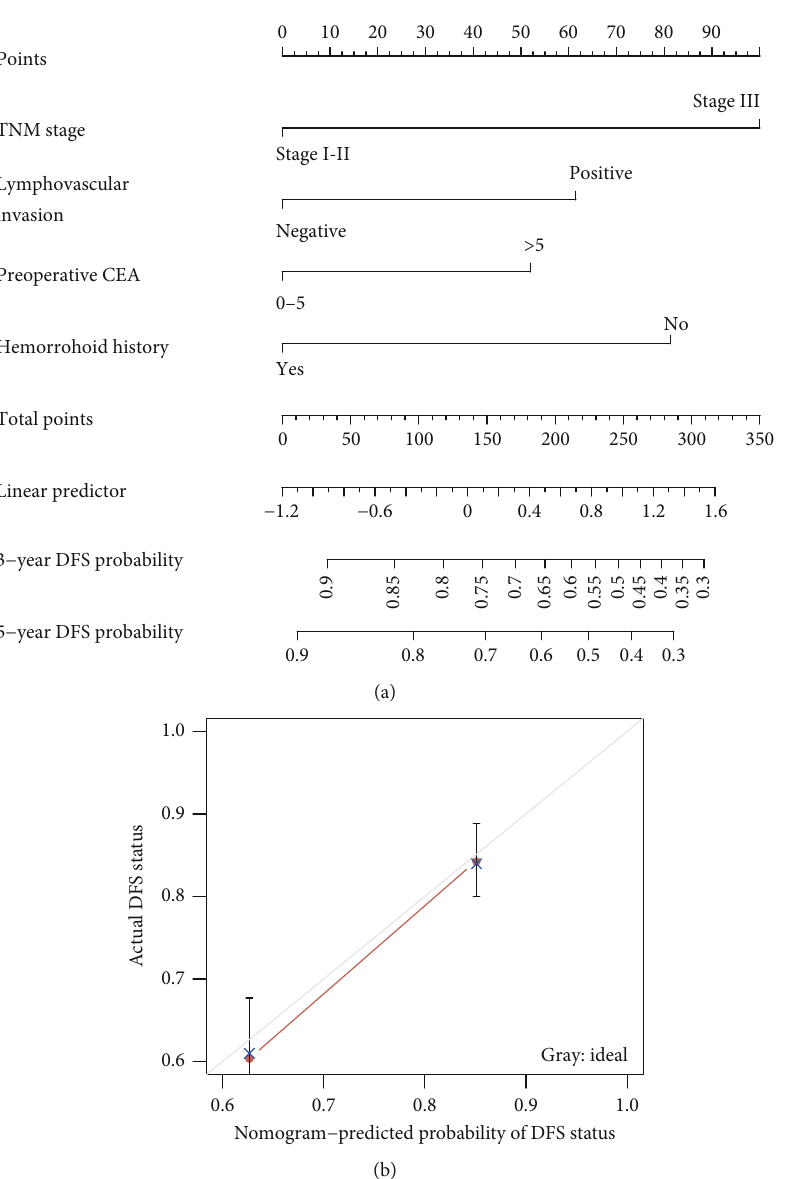
Figure 5: A nomogram and calibration curve for prediction of disease-free survival in rectal cancer. (a) A nomogram to predict individual patient-level 3-year and 5-year DFS based on hemorrhoid history and other clinicopathological risk factors. (b) Calibration plots for the internal validation of the nomogram. The observed DFS estimated by Kaplan-Meier was plotted against nomogram-predicted probability of DFS. 95% con fi dence intervals of the Kaplan-Meier estimates were indicated with vertical lines. Grayline indicated the reference line, showing where an ideal nomogram would lie. DFS: disease-free